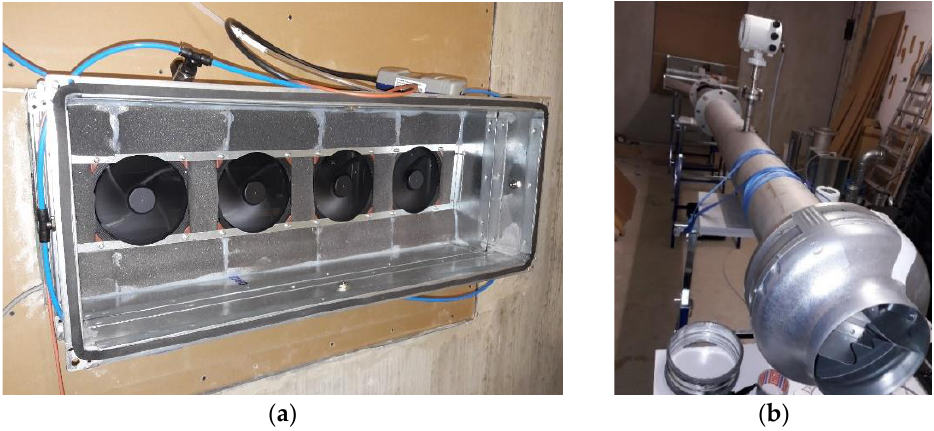
Figure 9. ( a ) Four parallel axial fans mounted in the channel section for acoustical and fan perfor- mance measurements and ( b ) the set-up of the test rig at UIBK.